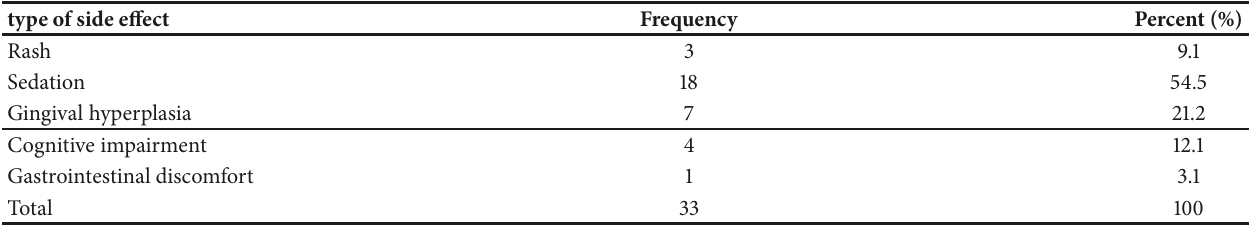
Table 1: Perceived type of side effect experienced by patients due to AED regimen at DRH, Dessie, Ethiopia, from April to June 2017.